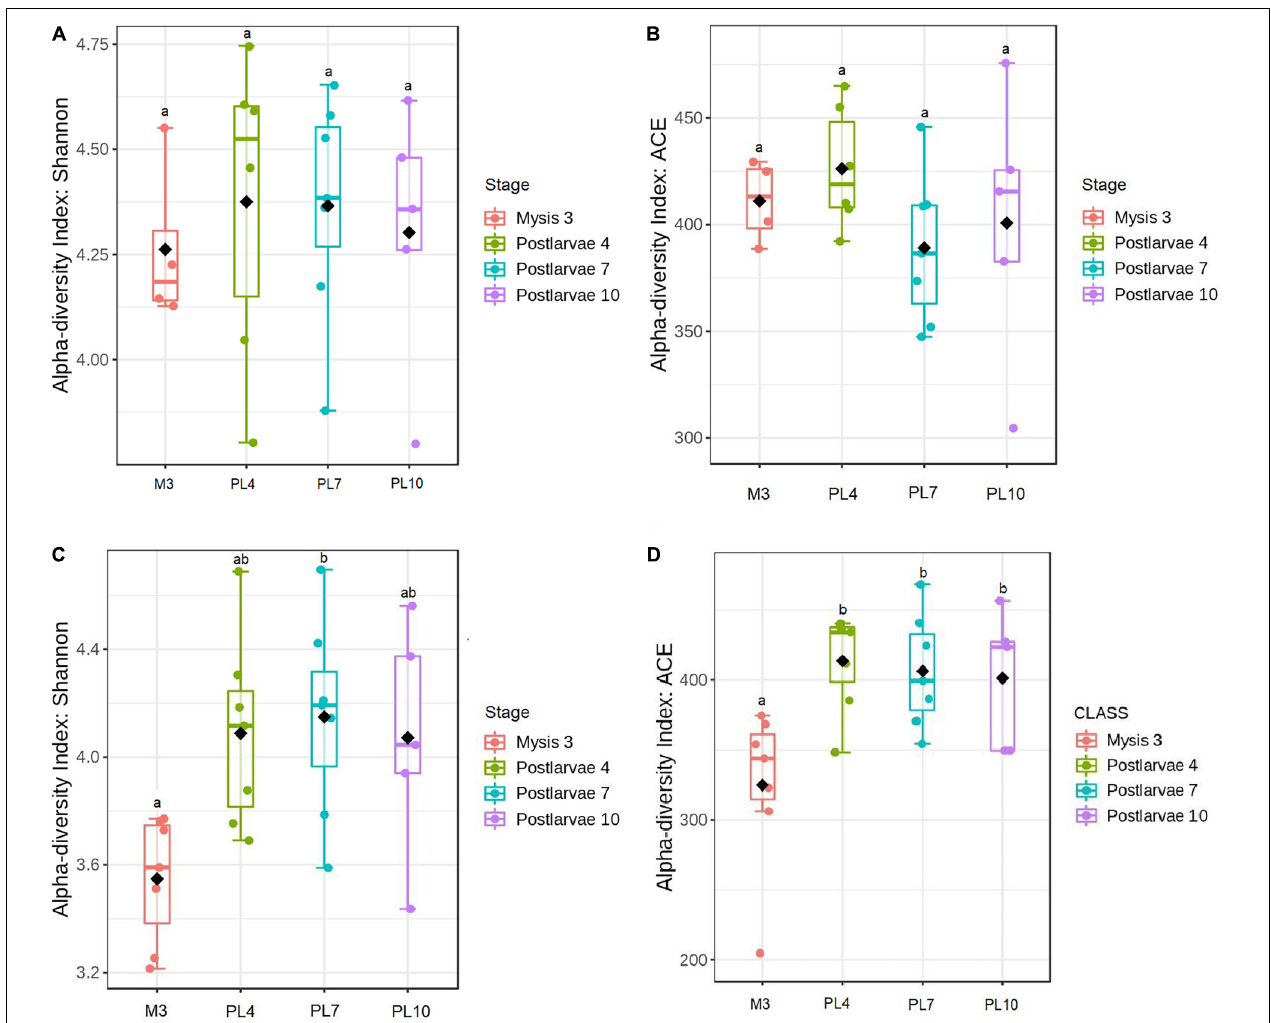
FIGURE 3 | Alpha-diversity of the larval microbiome at amplicon sequence variant (ASV) level in the high- and low-survival tanks affected by AHPND. (A) Shannon index for the high-survival tanks. (B) ACE index for the high-survival tanks. (C) Shannon index for the low-survival tanks. (D) ACE index for the low-survival tanks. At each survival condition, pair of larval stages with different letters indicates alpha-diversity indices significantly different at p < 0.05, based on the Tukey’s honestly significant difference